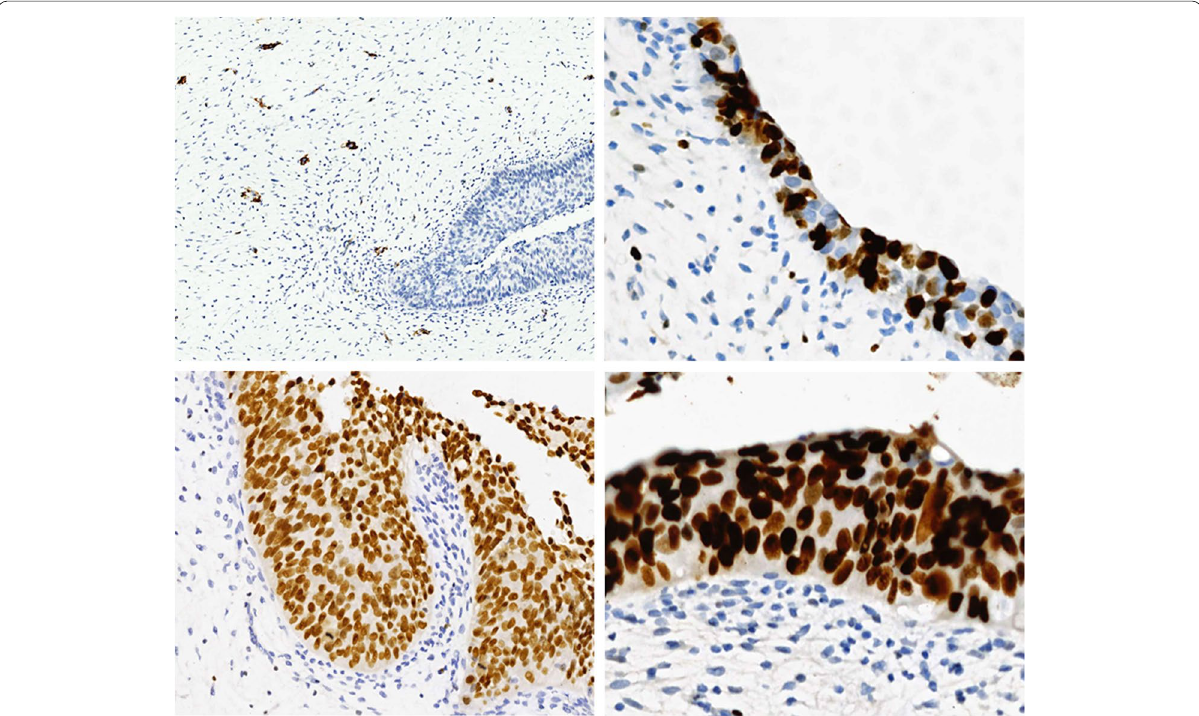
Fig. 4 Immunohistochemical findings of the resected tumor. a Negative staining of SMA was observed in the stromal component ( proliferation indexes of urothelial and stromal cells were 60% and 3%, respectively, as determined by Ki-67 staining